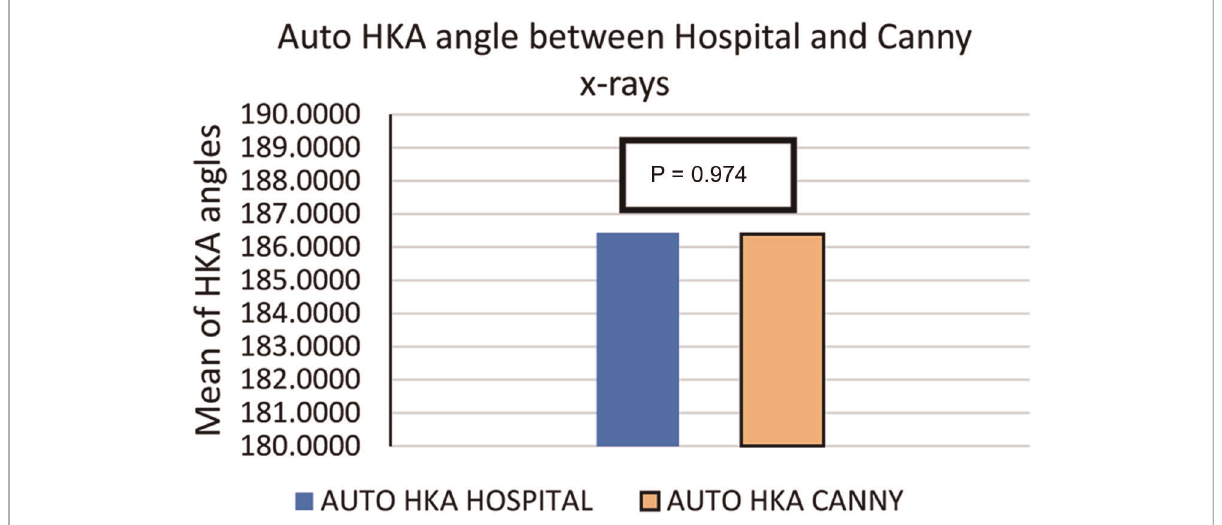
FIGURE 7 The mean of HKA angles for 28 sets of x-ray images stitched using our method and the x-ray radiographs obtained from the hospital directly, which were stitched by an expert.